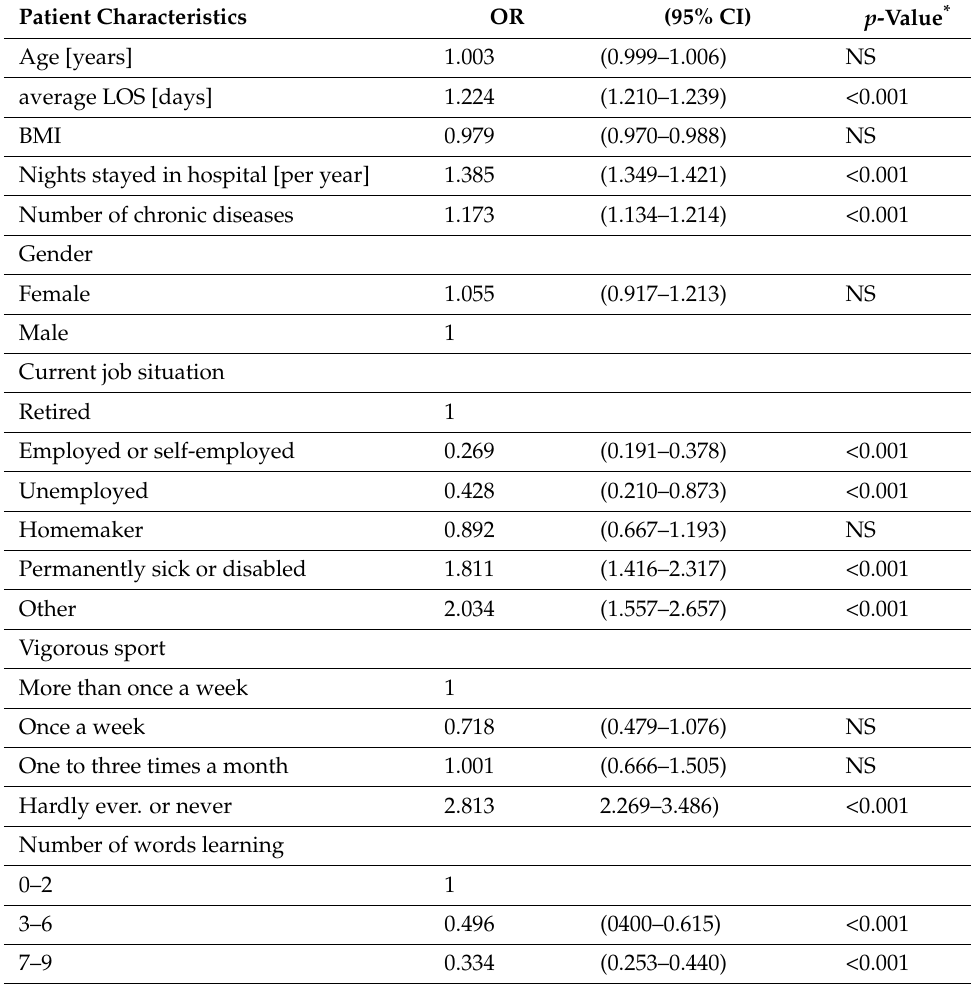
Table 4. Univariate analysis of factors associated with cost